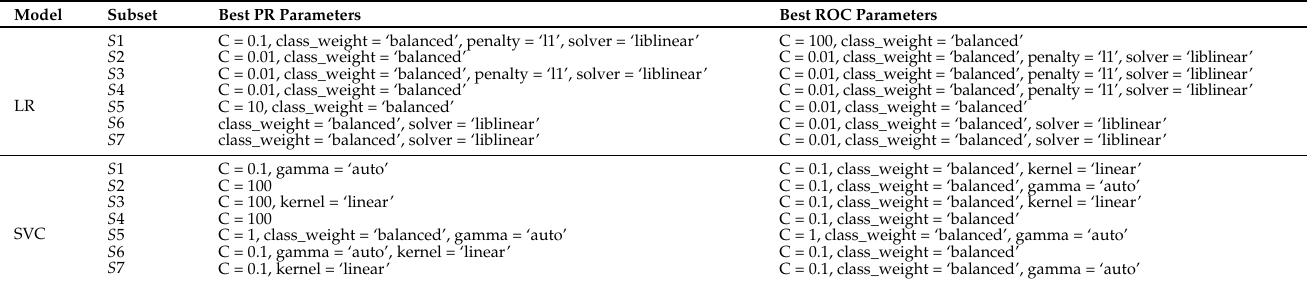
Table 4. The best hyperparameter settings for particular algorithms and attribute subsets identified by